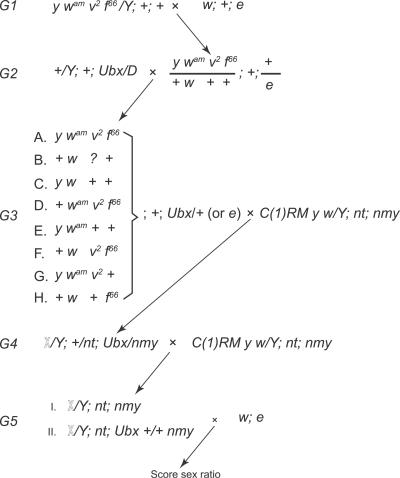
Cross Scheme for Mapping dox
One of the parental X chromosomes (y wam v2 f 66) has functional distorter(s), whereas the other (w) does not. Single-male matings were set up for all X chromosome recombinants in G3. All recombinants, represented by X in G4 and G5, were tested for sex-ratio in an isogenic background nt; nmy in G5 (I) as well as in a control background of nt; +/nmy (II). Two classes of recombinants (F and H) with the same visible phenotype were distinguished by progeny from additional crosses with y wam v2 f 66 females in G5. However, class B (+ w ? +) may be a mixture of + w + + and + w v2 +, which were not distinguished.